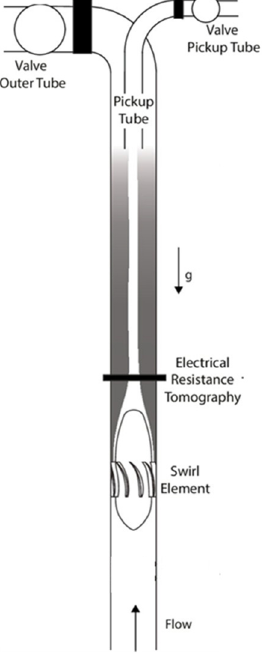
Figure 1. Schematics of the inline swirl separator with the sensor and pick-up tube considered in this research [7].